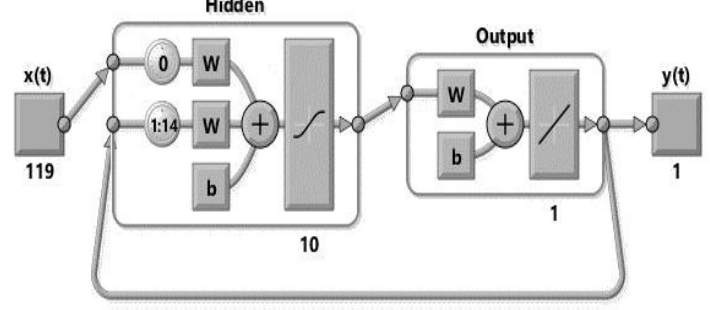
Figure 1. Schematic view of the NARX system as shown on a Matlab Mathworks visualization.